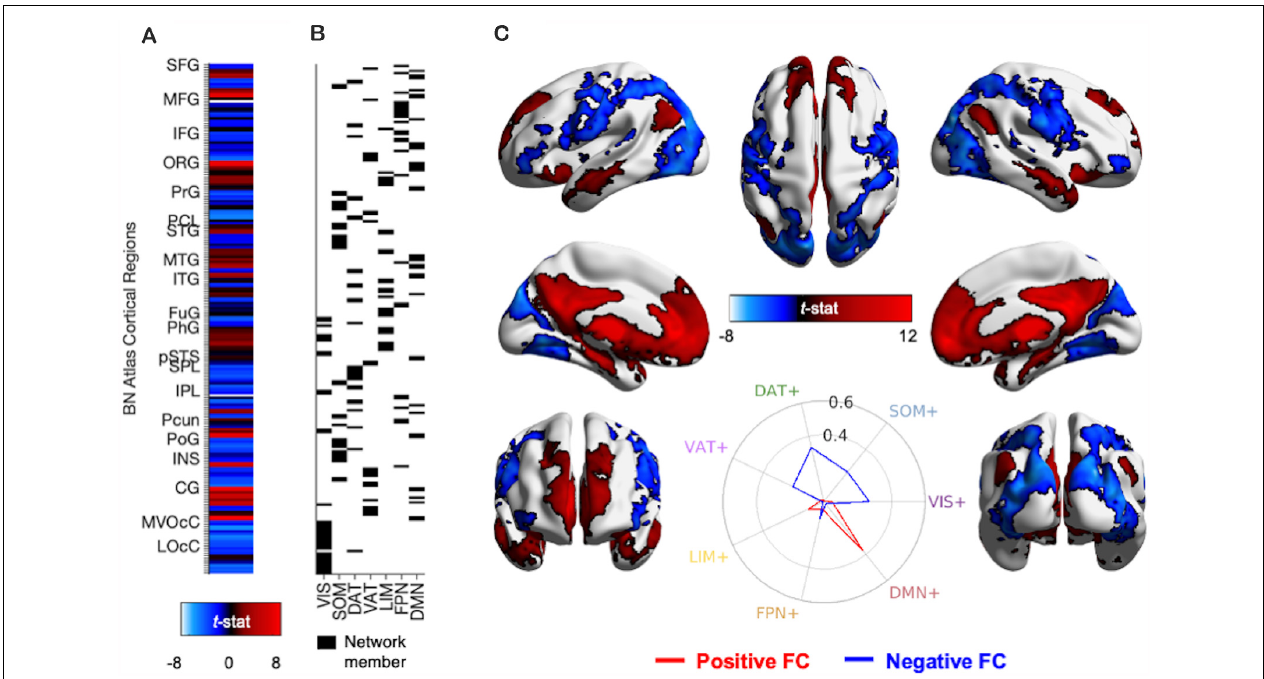
FIGURE 4 | Methods and results for identifying PVT functional connectivity macro-structures. (A) Semi-partial correlation statistics of PVT FC, controlling for the rest of the thalamus, were extracted from the 210 cortical regions of the BN Atlas to create an FC vector. (B) Cosine similarity between the positive FC values (shown in red) and negative FC values (shown in blue) and each of the seven binary vectors representing group membership to a 7-parcellation scheme from Thomas Yeo et al. (2011) were calculated separately. (C) Thresholded network rendered view of the same PVT functional connectivity maps shown in Figure 2 . Positive (red) and negative (blue) functional connectivity of the PVT, controlling for average signal from the rest of the thalamus. Results thresholded at p TFCE-FWE < 0.05. Inset polar plot depicts the results of the cosine similarity between the positive functional connectivity (red) and negative functional connectivity (blue) map statistics with binary vectors corresponding to known rest-state networks (Thomas Yeo et al., 2011). The positive FC correspondence is observable between the red region rows in (A) and the Default Mode Network (DMN) network membership column in (B) . Polar plots created using code from Cornblath et al. (2020). Abbreviations: CG, cingulate gyrus; DAT, dorsal attention network; DMN, default mode network; FPN, fronto-parietal network; FuG, fusiform gyrus; IFG, inferior frontal gyrus; INS, insula; IPL, inferior parietal lobule; ITG, inferior temporal gyrus; LIM, limbic network; LOcC, lateral occipital cortex; MFG, middle frontal gyrus; MTG, middle temporal gyrus; MVOcC, medio-ventral occipital cortex; OrG, orbital gyrus; PCL, paracentral lobule; Pcun, precuneus; PhG, parahippocampal gyrus; PoG, post-central gyrus; PrG, pre-central gyrus; pSTS, posterior superior temporal sulcus; SFG, superior frontal gyrus; SOM, somato-motor network; SPL, superior parietal lobule; STG, superior temporal gyrus; VAT, ventral attention network; VIS, visual